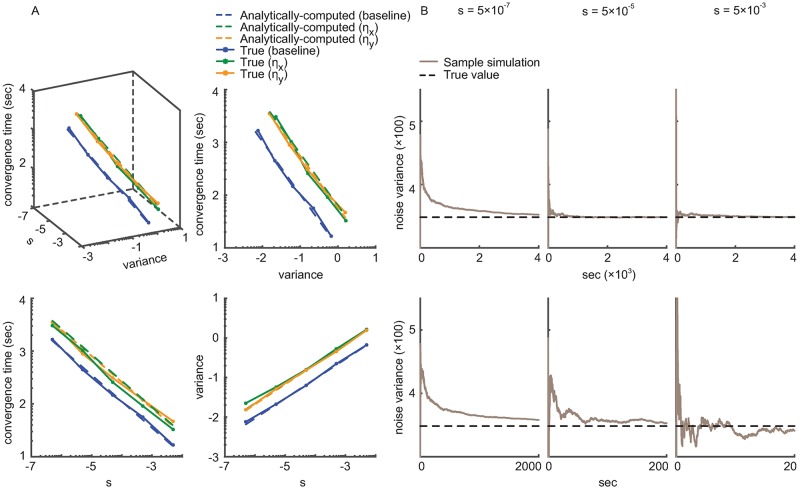
The calibration algorithm accurately computes the steady-state error covariance and convergence time as a function of learning rate for continuous signals.(A) The analytically-computed and the true error covariance and convergence time of the encoding model parameters (baseline, ηx, and ηy in (1)) for different learning rates s, across a wide range of s. The top left panel shows the relation between the three quantities. The other three panels are projections of this plot to three planes, showing each of the three pair-wise relationships. All axes are in log scale. True quantities are computed from BMI simulations with periodic center-out-and-back training datasets. The analytically-computed values are obtained by the calibration algorithm according to Eqs (7) and (8). The analytically-computed and true values match tightly across a wide range of learning rates, showing that the calibration algorithm can accurately compute the learning rate for a desired trade-off between steady-state error and convergence time. (B) Adaptive estimation of the unknown observation noise variance using (11) under different learning rates s. The bottom three panels are zoomed-in versions of the top panels to show the transient behavior of the estimated noise variance, which converges to its true value in all cases.